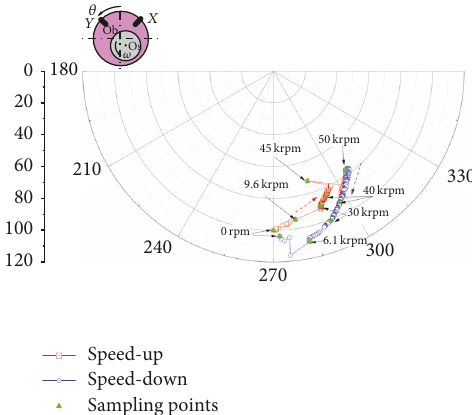
Figure 11: Polar plot of journal during the transient start-up and coast-down